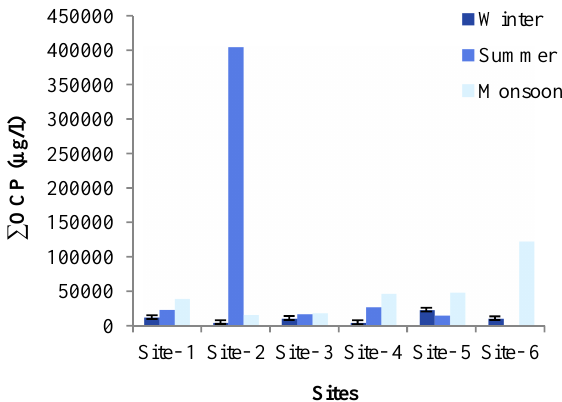
Figure 3. Seasonal variations of ∑ organochlorine pesticides (OCPs) residues in the Sabarmati River The river flow, during the winter, becomes normalized and the river system starts to stabilize with the settling of eroded